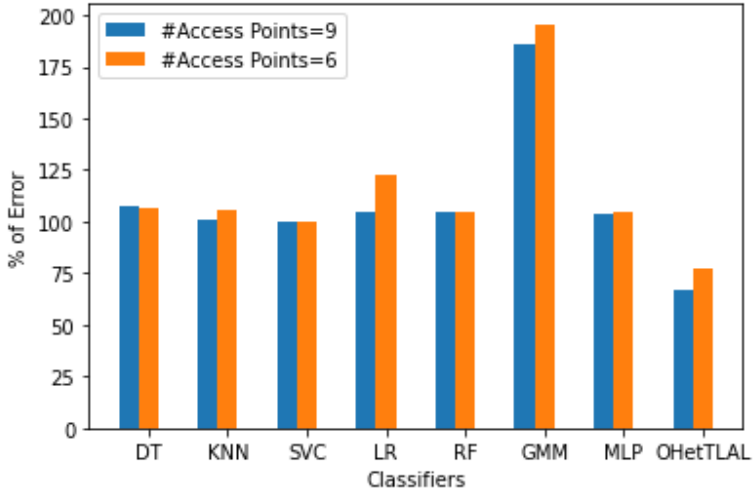
Figure 22. Comparison of performance of the classifiers for dataset B with 9 and 6 APs.